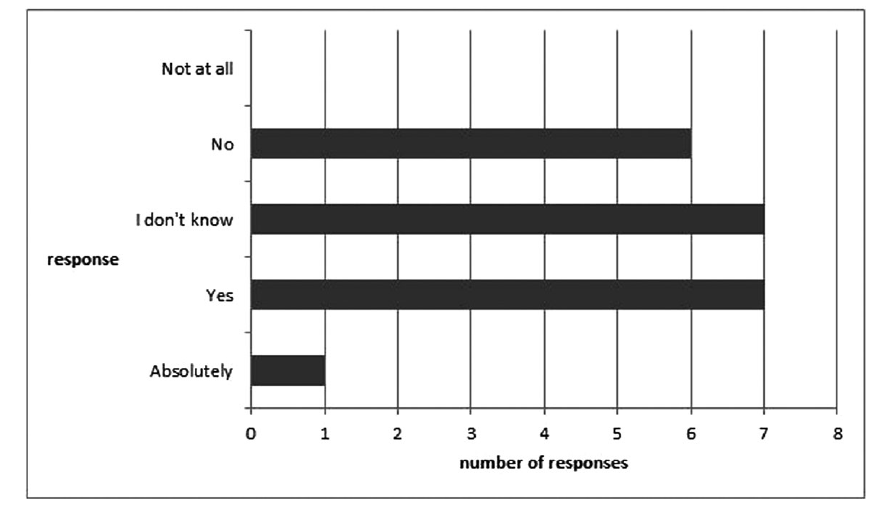
Responses to question from Mindmatters Survey: The school provides opportunities for the families and communities to hear about mental health and wellbeing initiatives and to share their ideas and experiences. Note: Adapted from Ninti One 2013, p. 28.